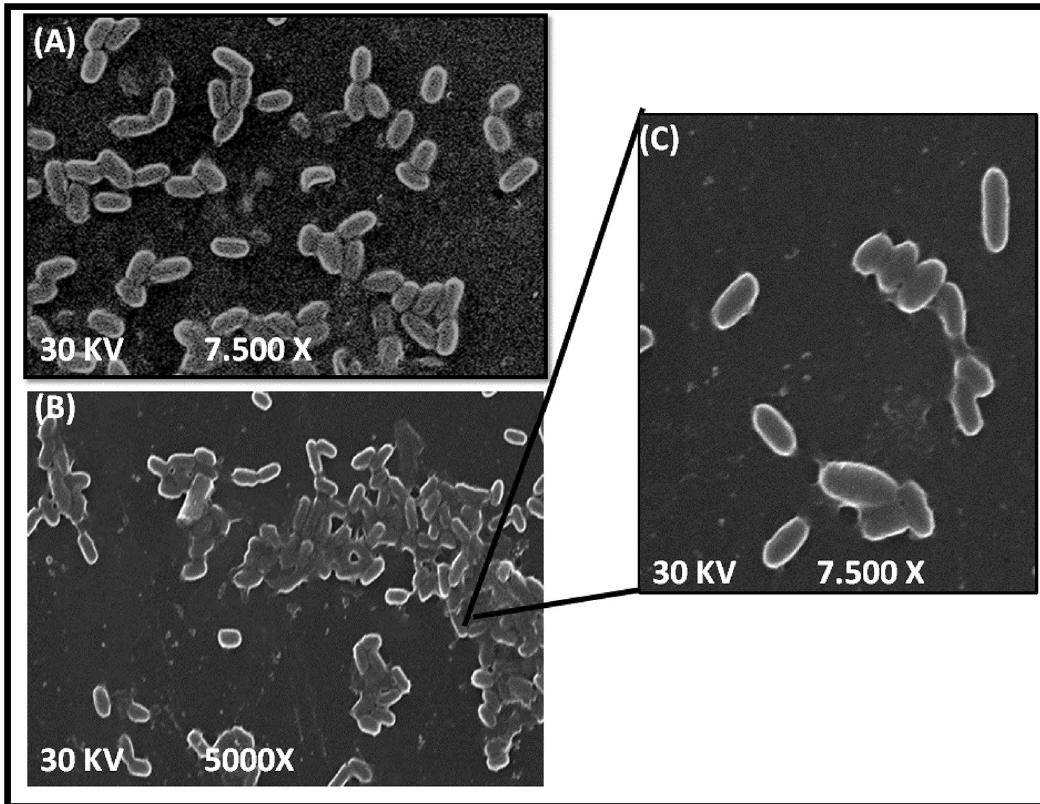
Figure 7. SEM image of P. alcaliphila NEWG-2 without MB ( A ), and bacterial cells treated with MB ( B , C ) at different